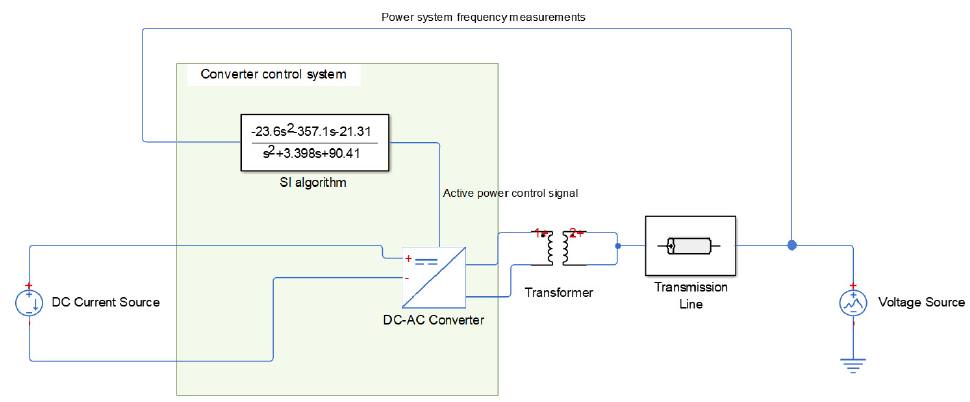
Figure 12. Simplified flowchart of the SI algorithm implementation.